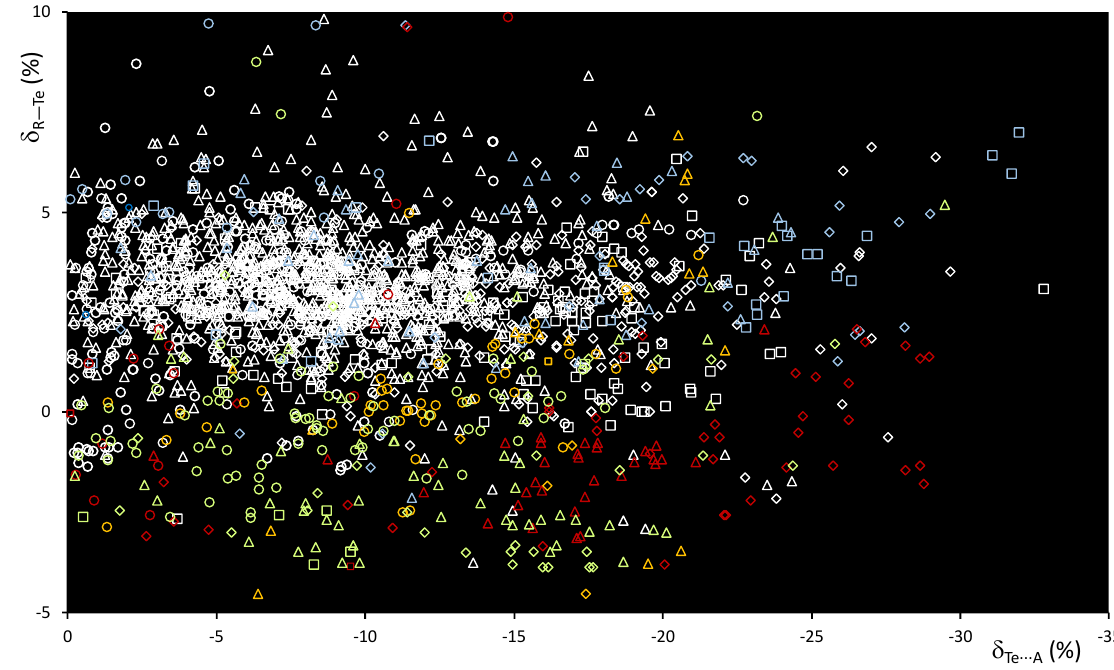
Figure 9. Scatterplot of the δ R–Te vs. δ Te ··· A functions calculated for fragments R–Te · · · A. R = C (white), O (red), N (light blue), S (yellow), Se (magenta), and Te (acid green); A = N (square), O (rhomb), Ch (circle), and Ha (triangle). The mean values δ Te ··· A reported in Figure 10 and Table 3 for the R–Te · · · A fragments indicate an increase in the strength of the related ChBs as compared with the R–Se · · · A systems. Table 3. Mean of δ Te ··· Aa values ( δ Te ··· A ) and Nc b values calculated for the fragments R–Te · · · A. R = C, N, O, S, Se, and Te; A = N, O, S, Se, Te, F, Cl, Br, and I.